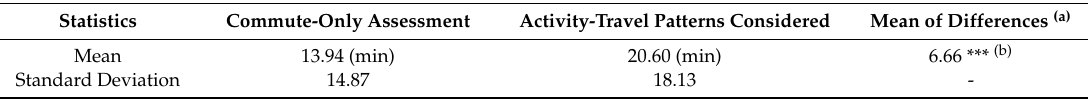
Table 3. Mean exposure to traffic congestion in the commute-only assessment and the assessment that also considers participants’ activity-travel patterns.